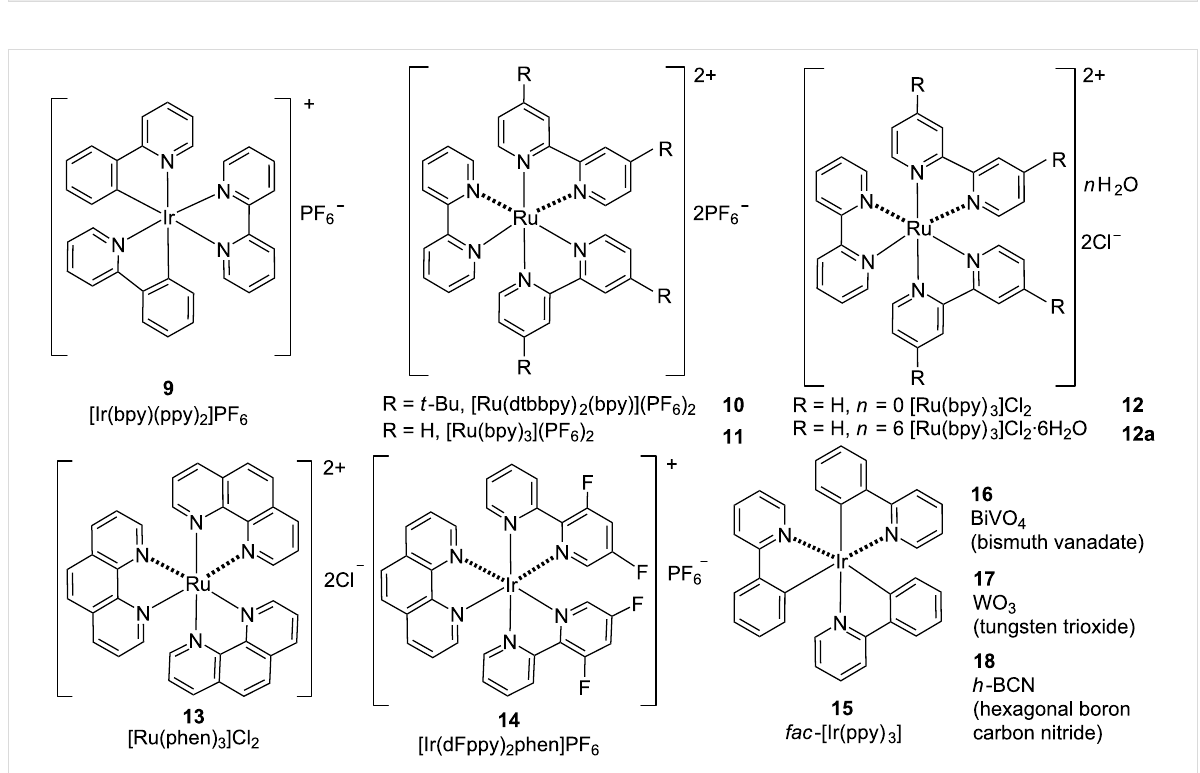
Figure 2: List of metal-based photoredox catalysts used in this review